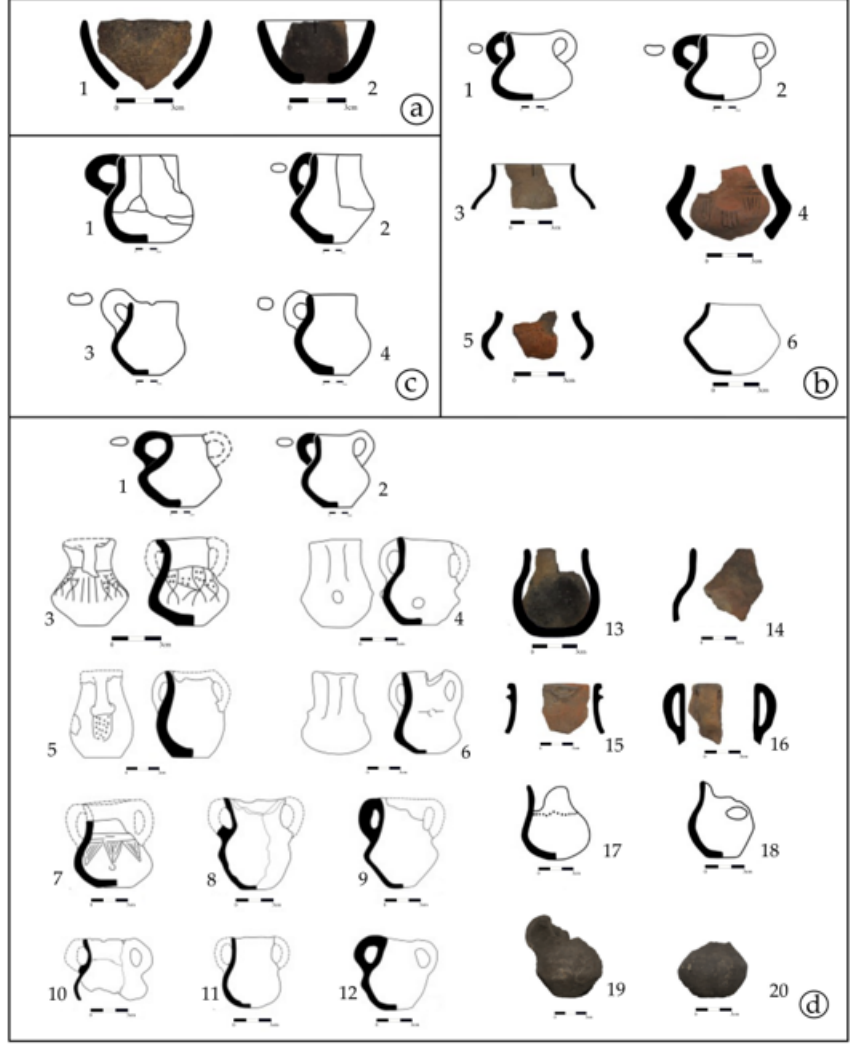
Figure 2. Costis a miniature vessels: ( a ) vessels for preparation, serving and consumption; ( b ) vessels , with multiple purpose; ( c ) drinking vessels; ( d ) vessels for storage or transportation of